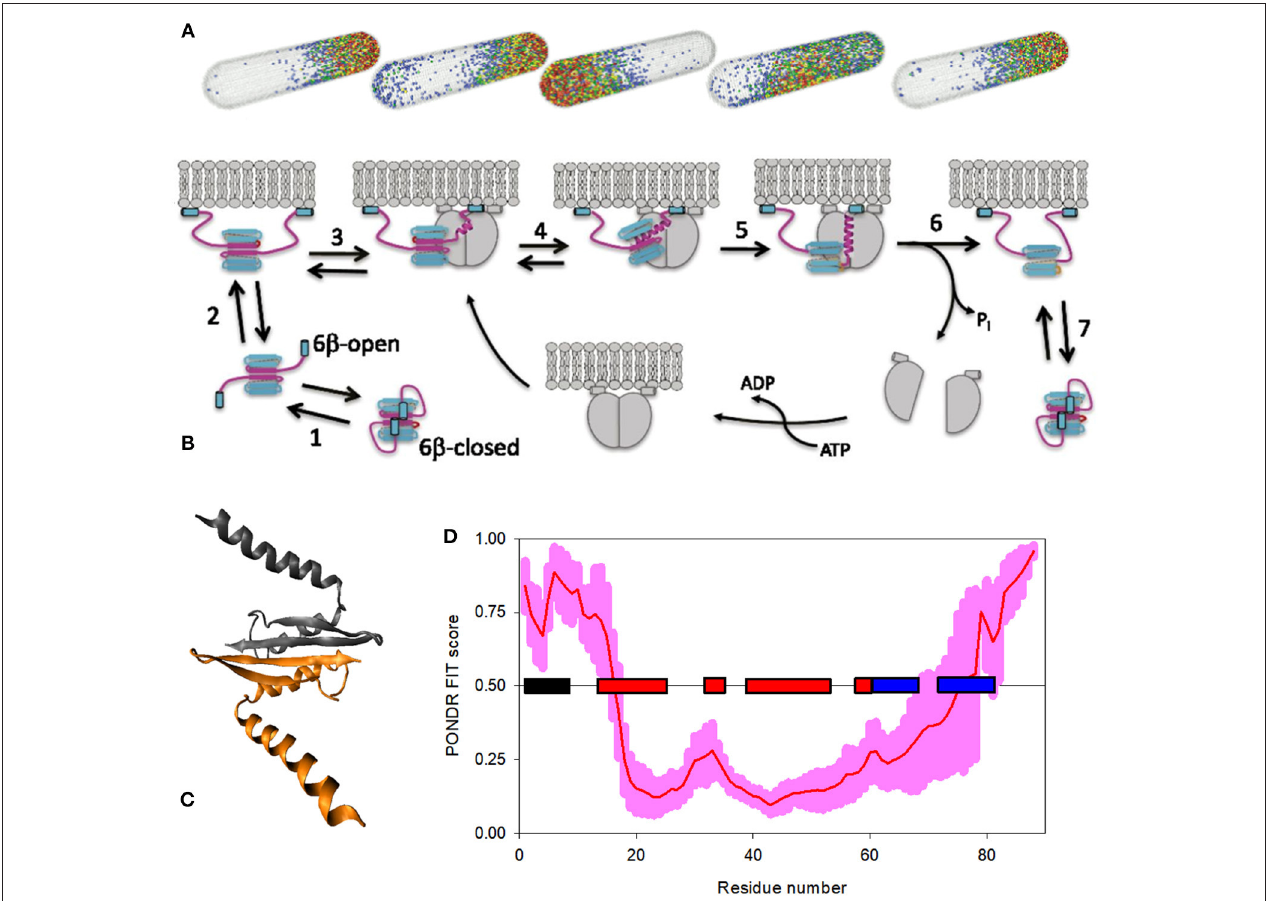
FIGURE 4 | Bacterial Min proteins, as an illustration of a system with disorder-based emergent behavior. (A) A model showing the pole-to-pole oscillations of the members of MinE system in a rod-shaped structure with the length of 3.8 µ m [167]. Modified with permission from [167]. (B) Model describing activation of MinE by interaction with MinD [ 168]. Here, the latent 6 β -stranded form of MinE exists in two conformations, closed and open, which are in the rapid exchange (step 1). Open form can reversibly interact with the membrane via its MTSs (step 2). Once the loop region connecting MTS with the remaining MinE body encounters MinD, it undergoes a disorder-to-order transition, forming a nascent α -helix (step 3). Next, the long α -helix is formed by conversion of the β 1 strand into a helical state, resulting in the creation of an active 4 β -stranded form caused by the dissociation of this N-terminal region from the MinE dimer interface (step 4). The subsequent stabilization of this contact α -helix is achieved by its binding to the MinD dimeric interface, leading to the formation of MinE-MinD complex (step 5), leading to the stimulation of the MinD ATPase activity, ATP hydrolysis, and the release and dissociation of MinD dimer (step 6). If the MinE does not encounter another MinD, it spontaneously returns to the latent form (step 7). Therefore, following the dissociation of MinD, the fate of MinE depends on two competing reactions: it is either handed off to another MinD, or dissociates from the membrane and snaps back to the 6 β -stranded structure. A higher density of MinD on the membrane favors the former [168, 169]. (C) Crystal structure of the MinD-bound MinE dimer from E. coli (PDB ID: 3R9J). (D) PONDR ® FIT-generated disorder profile in the E. coli MinE protein. The light pink shadow shows the distribution of statistical errors of the PONDR ® FIT prediction. MTS and the elements of MinE secondary structure, α -helices, and β -strands, are correspondingly shown as black, red, and blue bars located in the middle of the